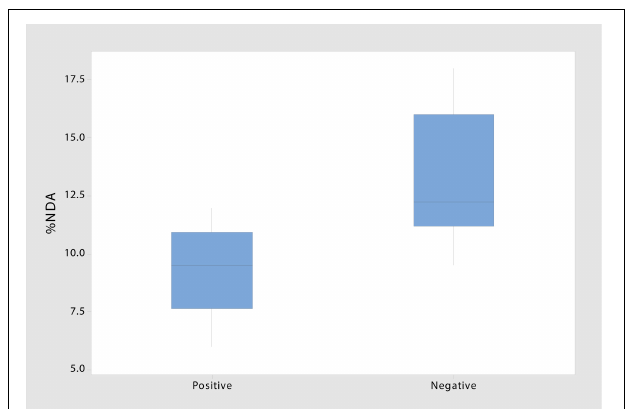
FIGURE 4 | Decomposition ability of taxa testing negative for laccase and peroxidase enzymes involved in lignin degradation is significantly higher than that of taxa testing positive (T-stat = 3.09; p = 0.009) ( n = 8).